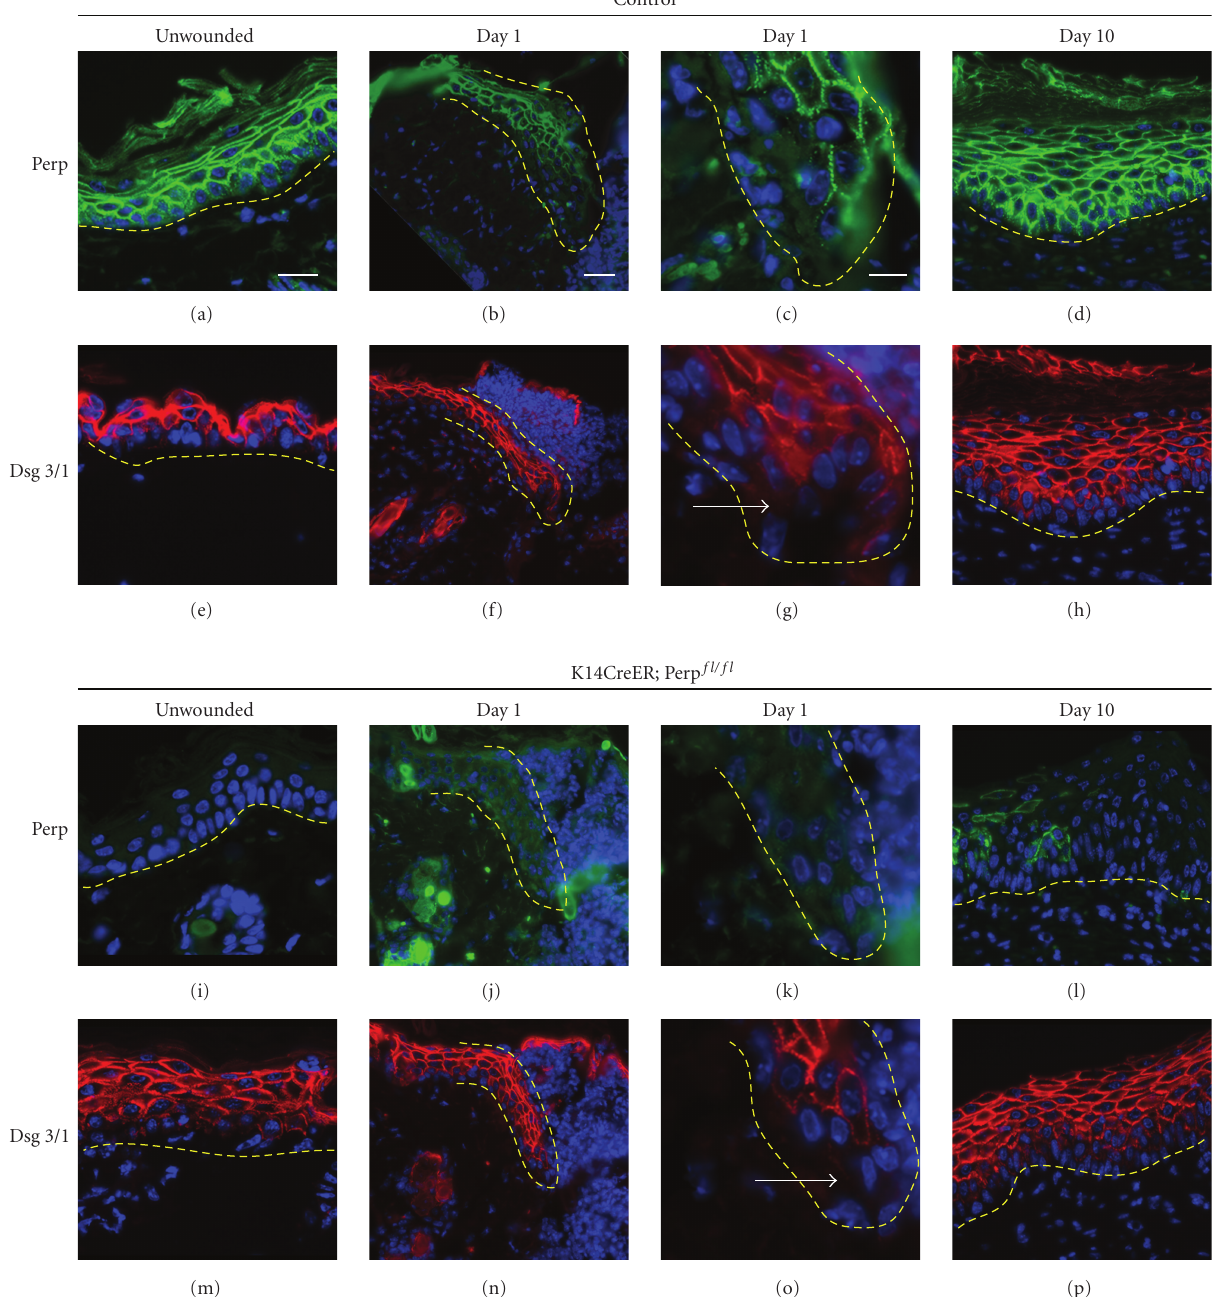
Figure 4: Migrating keratinocytes display reduced desmosomal protein expression at the wound edge. (a)–(d) Immunofluorescence images of Perp expression in the epithelium at di ff erent timepoints post wounding in control mice. The dashed yellow line represents the border between the migrating keratinocytes and underlying dermis. (e)–(h) Desmoglein 3/1 expression at di ff erent timepoints post wounding in control mice (tamoxifen-injected Perp fl/fl mice). (i)–(l) Immunofluorescence images of Perp expression in the epithelium at di ff erent timepoints post wounding in K14CreER; Perp fl/fl mice. (m)–(p) Desmoglein 3/1 expression at di ff erent timepoints post wounding in K14CreER; Perp fl/fl mice. DAPI is used to mark nuclei. Arrows indicate cells with reduced desmosomal protein staining. Scale bar in (a) equals 20 μm , scale bar in (b) equals 50 μm , and scale bar in (c) equals 10 μm